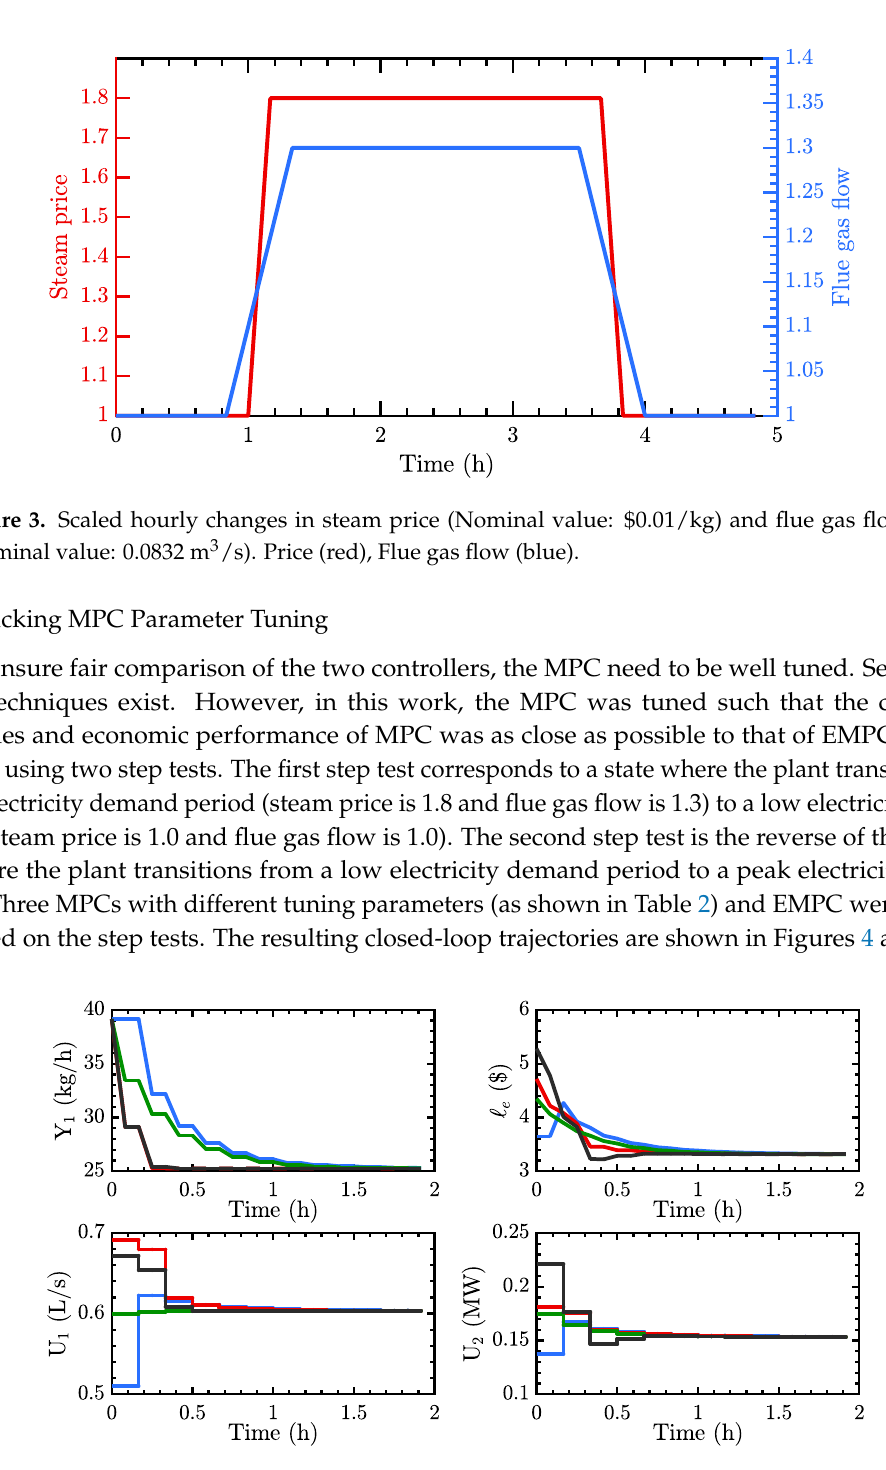
Figure 4. Closed-loop trajectories of EMPC and different MPC tuning parameters starting from a higher economic cost to a lower one. EMPC (blue), MPC I (red), MPC II (green), MPC III (black). The average economic performances are 4.700, 4.768, 4.713, 4.692 for EMPC, MPC I, MPC II, MPC III, respectively; ( top-left ) mass flow rate of CO 2 in the treated flue gas; ( top-right ) economic performance of controller; ( bottom-left ) volumetric flow rate of solvent; ( bottom-right ) heat input to reboiler. EMPC: Economic Model Predictive